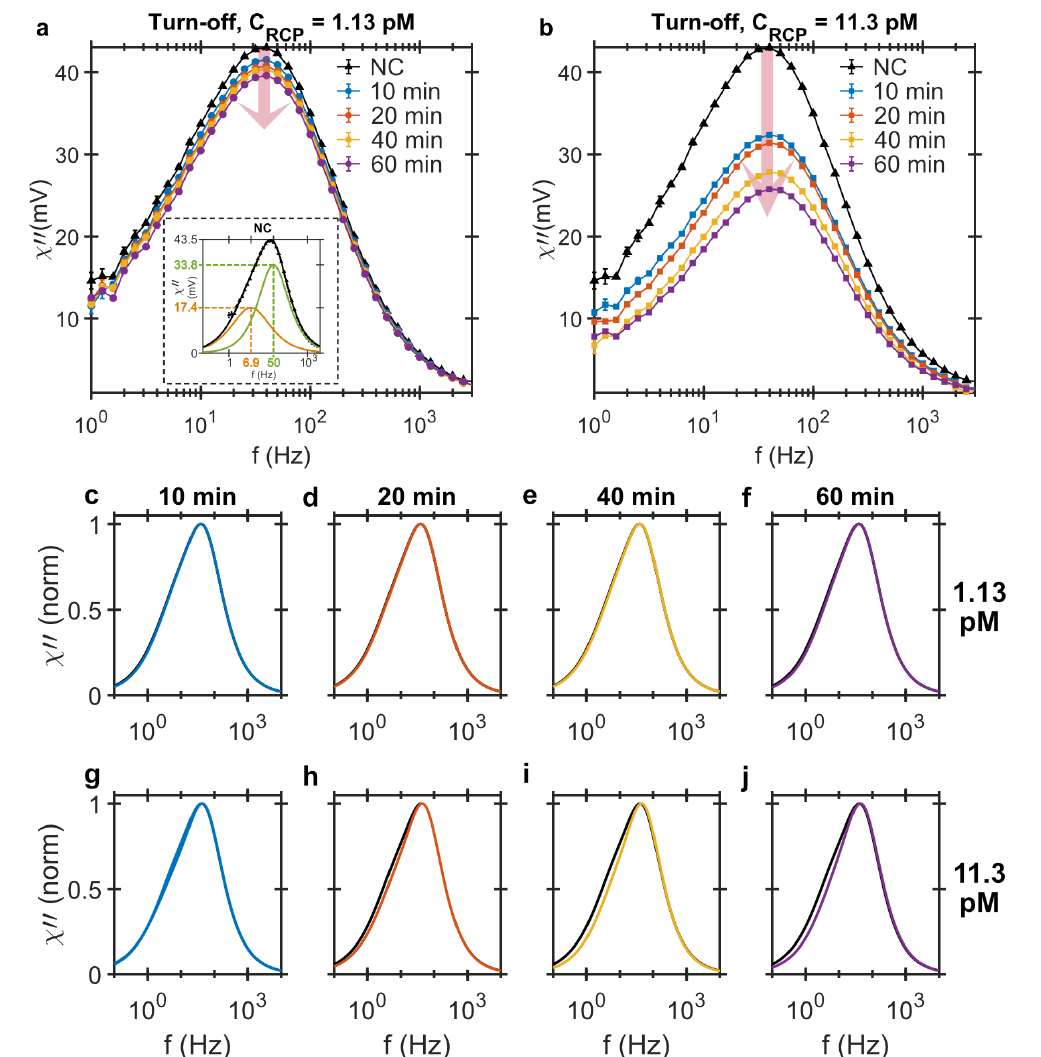
Figure 1. Imaginary component of ac magnetic susceptibility measured using the turn-off detection strategy versus the excitation frequency from MNP-labeled RCPs of ( a ) 1.13 pM and ( b ) 11.3 pM in concentration amplified for 10, 20, 40 and 60 min. The samples are diluted in hybridization buffer. The signals’ peak amplitudes decrease with increasing the RCP concentration and amplification time. The inset in ( a ) shows the bi-modal Cole-Cole model fitted to the imaginary component of the NC sample and shows that the MNP system has an intrinsic bi-modal size distribution with corresponding Brownian relaxation frequencies of 7 and 50 Hz; ( c – j ) Normalized bi-modal Cole-Cole model fitted to the imaginary component of ac susceptibility in the turn-off detection method for the magnetically labeled RCPs of ( c – f ) 1.13 pM and ( g – j ) 11.3 pM rolled for 10, 20, 40 and 60 min. The black curve that is present in all the panels corresponds to the bi-modal model fitted to the NC